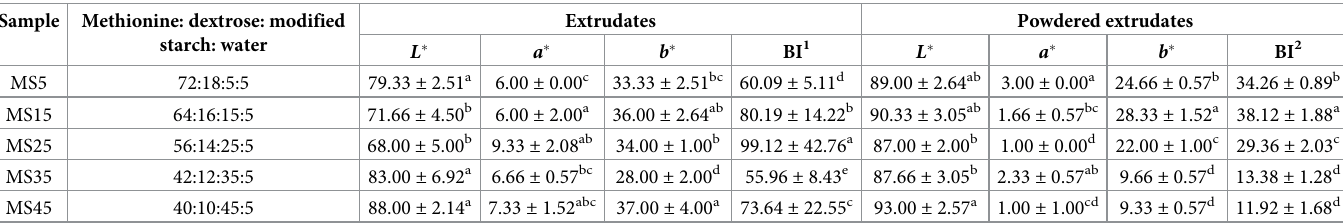
Means ± SD in the same column, followed by the same letter, are not significantly different at p < 0.05. BI 1 = Browning index of extrudates BI 2 = Browning index of powdered extrudates